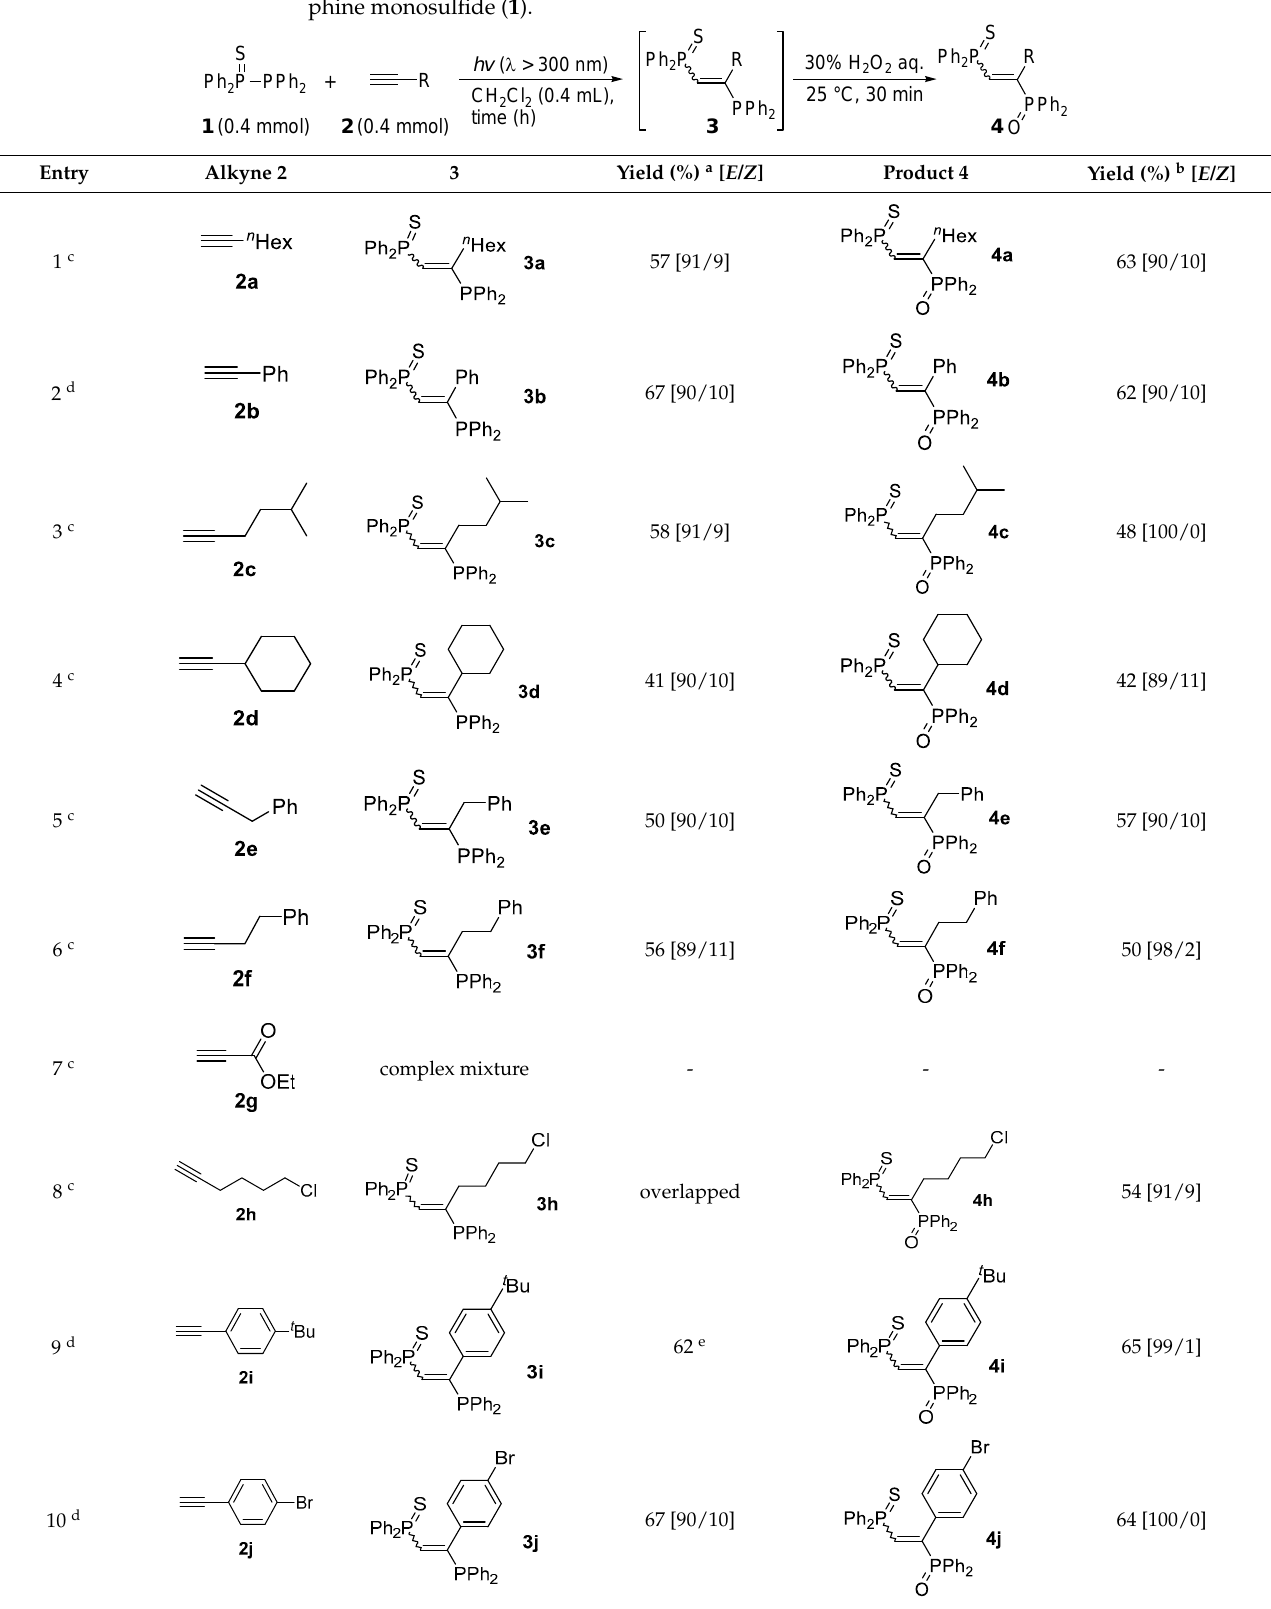
Table 3. Substrate scope for the photoinduced bisphosphination of alkynes with tetraphenyldiphos- phine monosulfide ( 1 ).